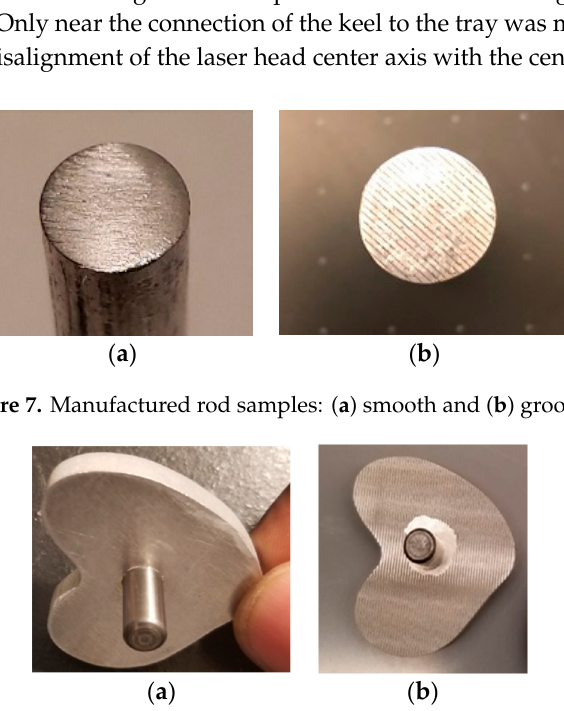
Figure 8. Manufactured TT samples: ( a ) smooth and ( b ) grooved.